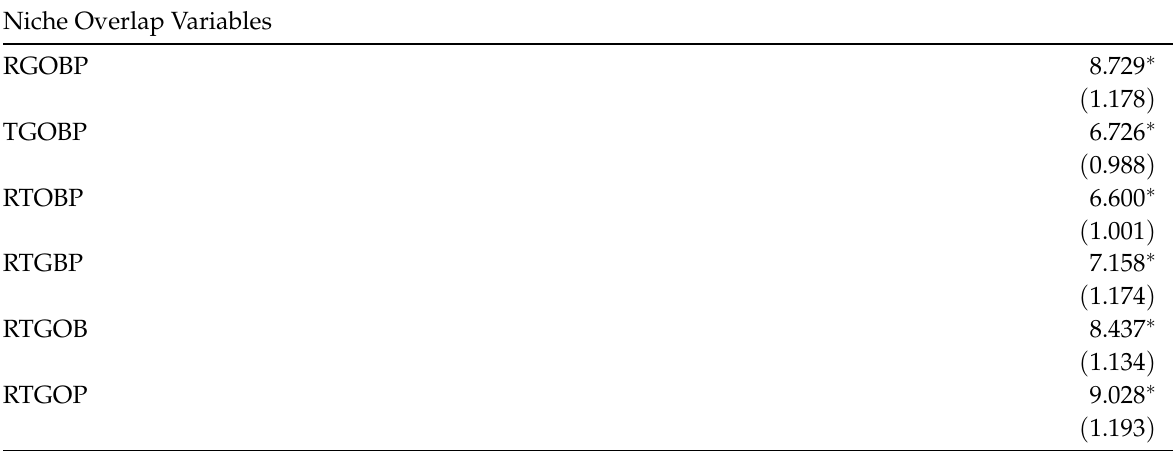
Table 5: Maximum-Likelihood Estimates of Informing during the HUAC Hearings — Robustness Tests (Cross Random-Effects Logistic